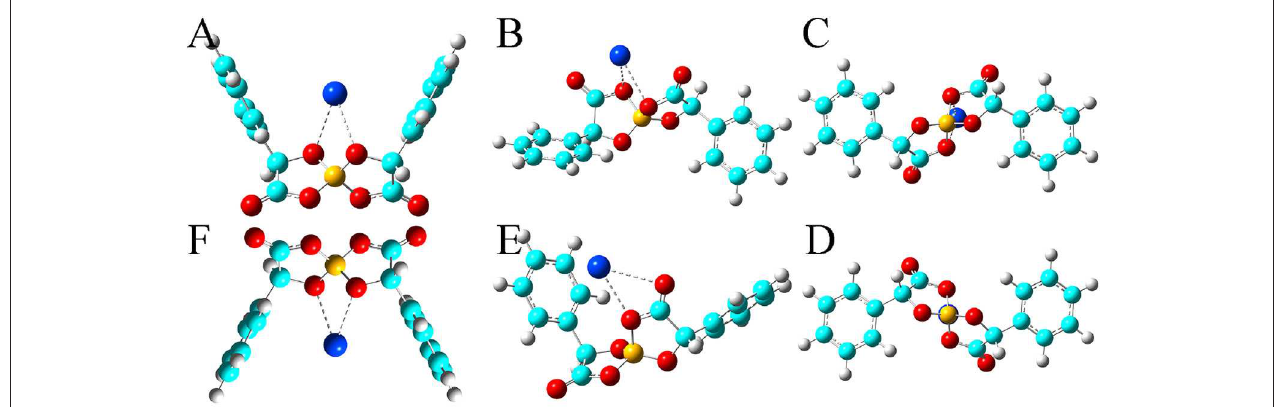
FIGURE 5 | Optimized ion-pair structures of a K + ion in coordinating [BMB] anions with varied molecular chiralities determined from DFT calculations. The hydrogen, boron, carbon, and oxygen atoms in [BMB] anions are represented by white, yellow, cyan, and red spheres, respectively, and K + ions are represented by blue